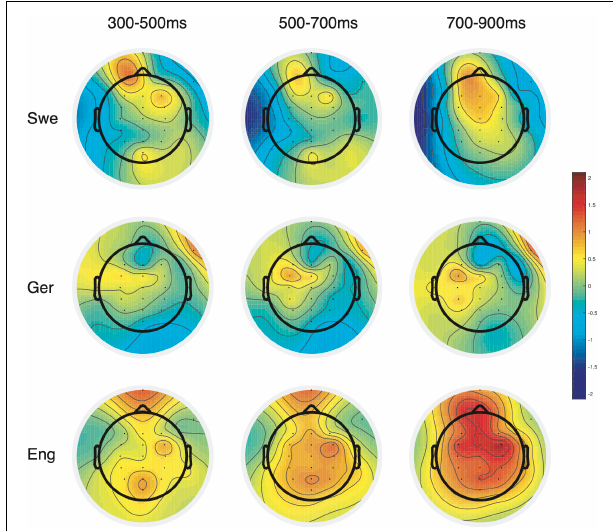
FIGURE 6 | Topographic maps of the ERP effects on the usage of Swedish placement verbs. Columns represent time windows used in statistical analyses of the ERP effects, while rows indicate the effects in Swedish native speakers (Swe), German learners (Ger), and English learners (Eng). These visualizations of the ERP effects show how the effects in German learners are more similar to Swedish native speakers than English